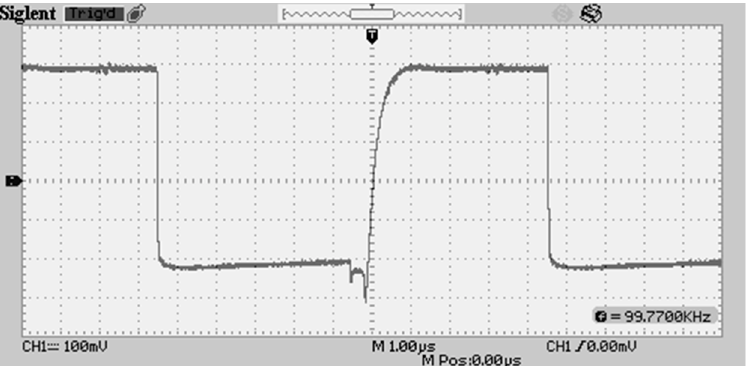
Figure 6. Previous waveform delivered to the sensing element.